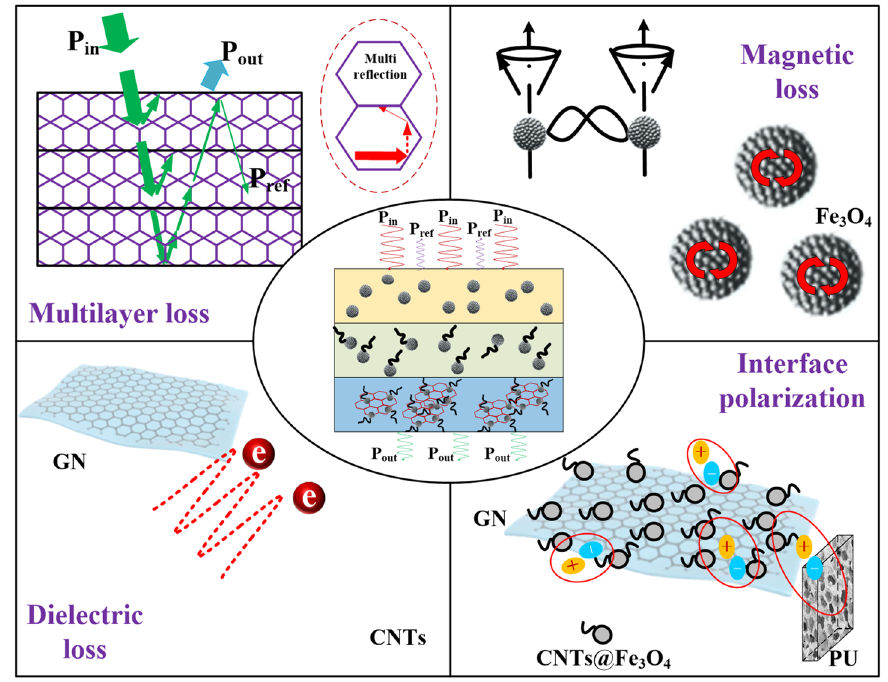
Figure 10. Electromagnetic wave absorption mechanism of three-layer electromagnetic foam.